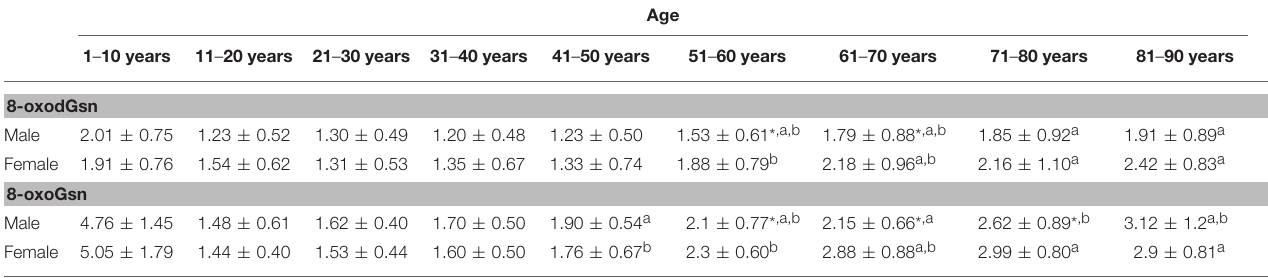
TABLE 2 | Age- and gender-specific levels for urinary 8-oxodGsn/crea and 8-oxoGsn/crea ( µ mol/mol) derived from 1,228 normal subjects.